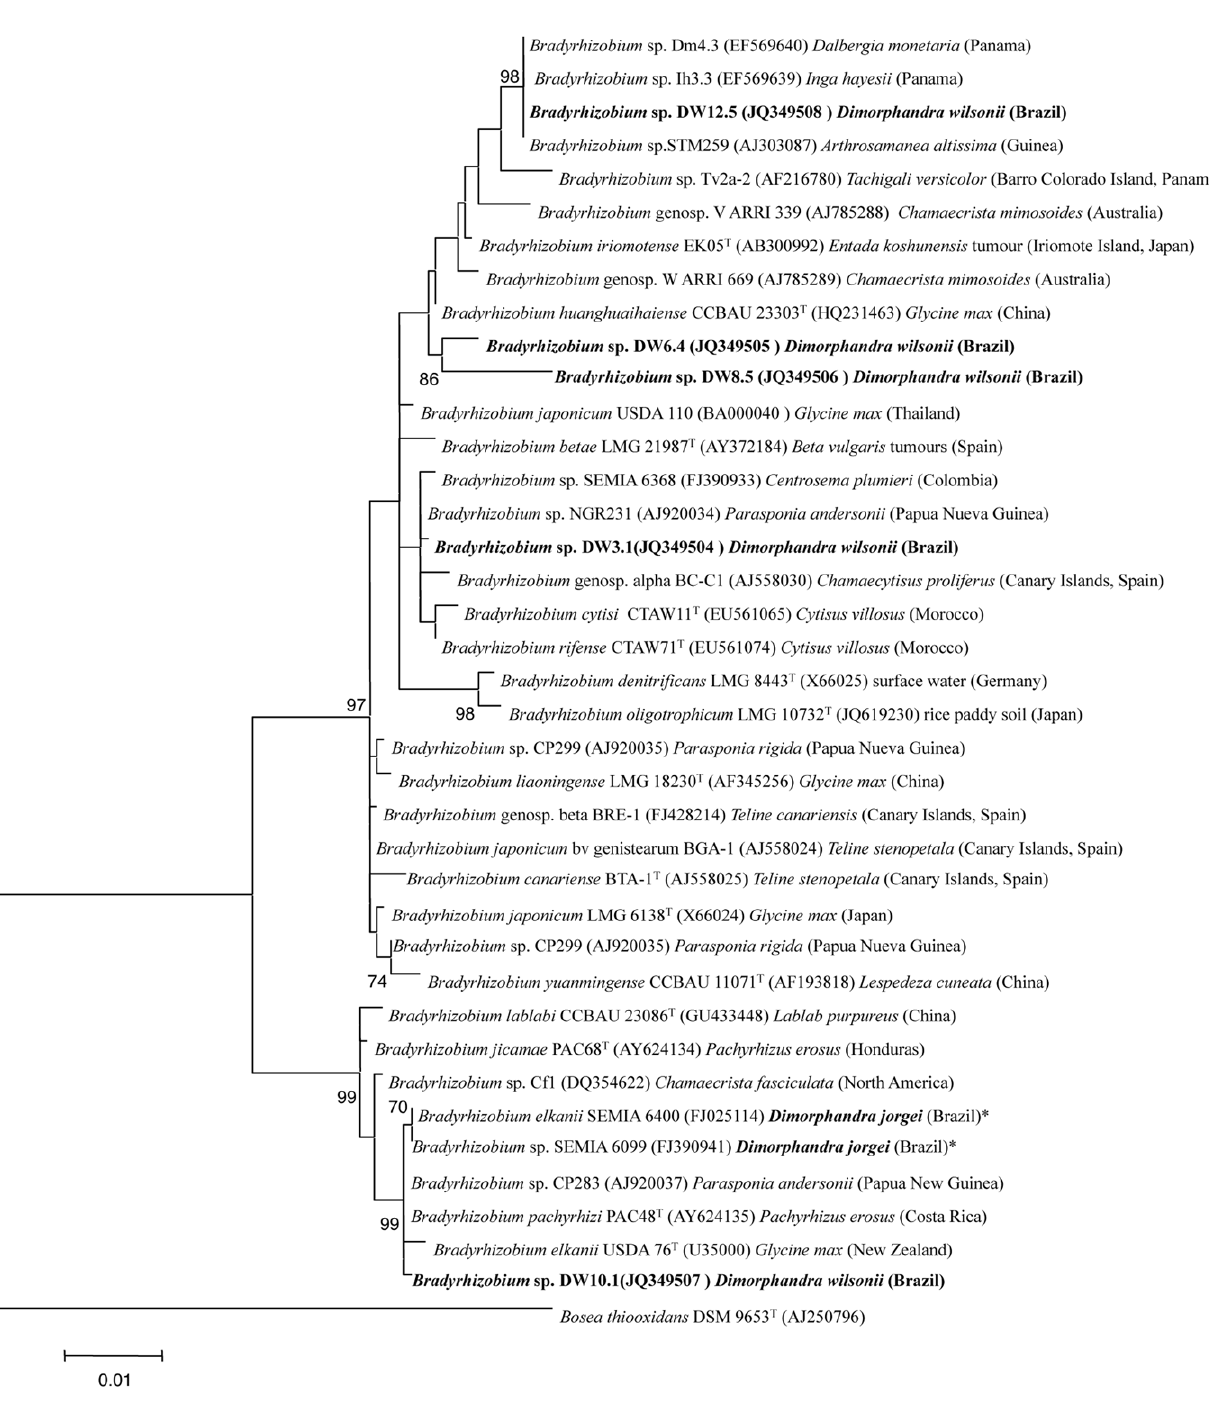
Figure 6. Maximum likelihood phylogenetic tree based on rrs (16S rRNA) gene sequences (1348 nt) showing the position of strains isolated from Dimorphandrawilsonii nodules within the genus Bradyrhizobium . Bootstrap values were calculated for 1000 replications. Bar, 1 nt substitution per 100 nt.